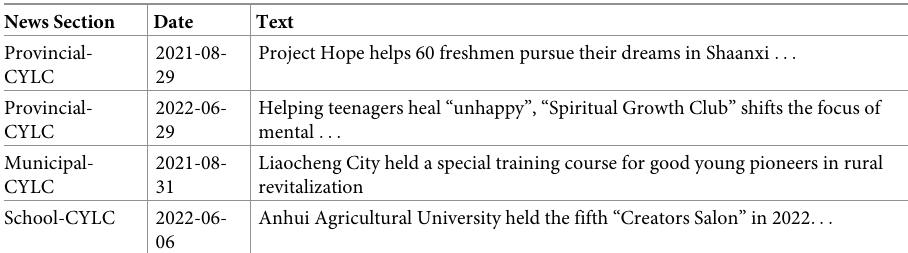
Table 4. A structured news